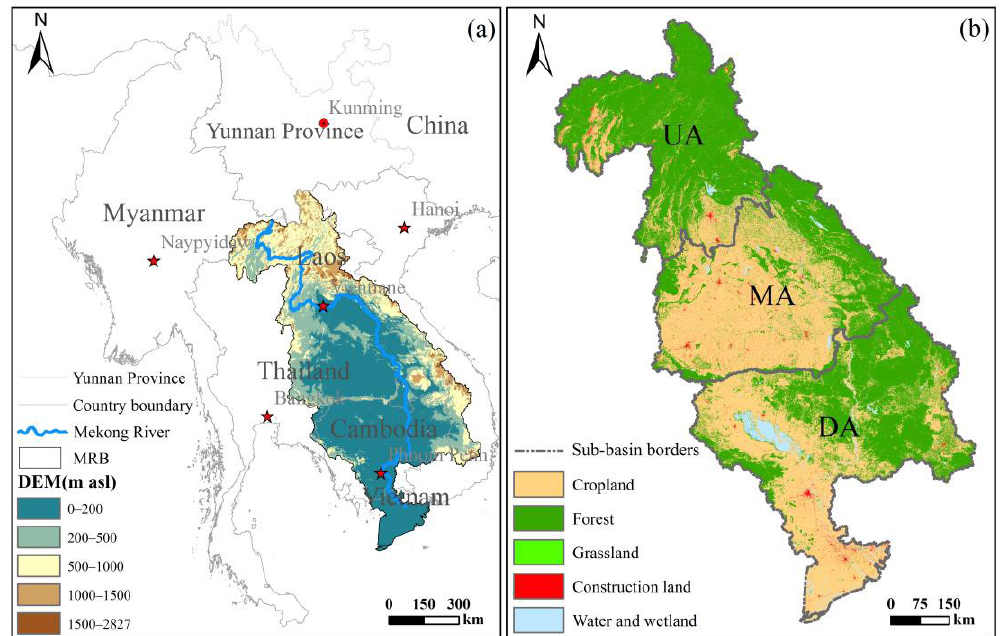
Figure 1. The maps of ( a ) the Mekong River Basin (MRB) and its topography (Advanced Spaceborne Thermal Emission and Reflection Radiometer Global Digital Elevation Model Version 3; ASTER GDEM V3) showing the ( b ) land use in 2020; UA, MA, and DA represent the upstream, midstream, and downstream areas of the MRB,